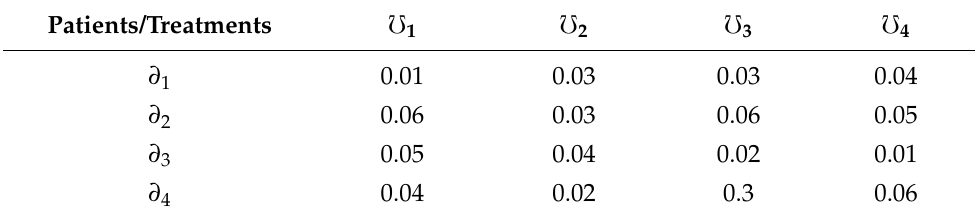
Table 17. W 4 tabular representation: After the fourth therapy event, the patient’s improvement report. C Patients/Treatments